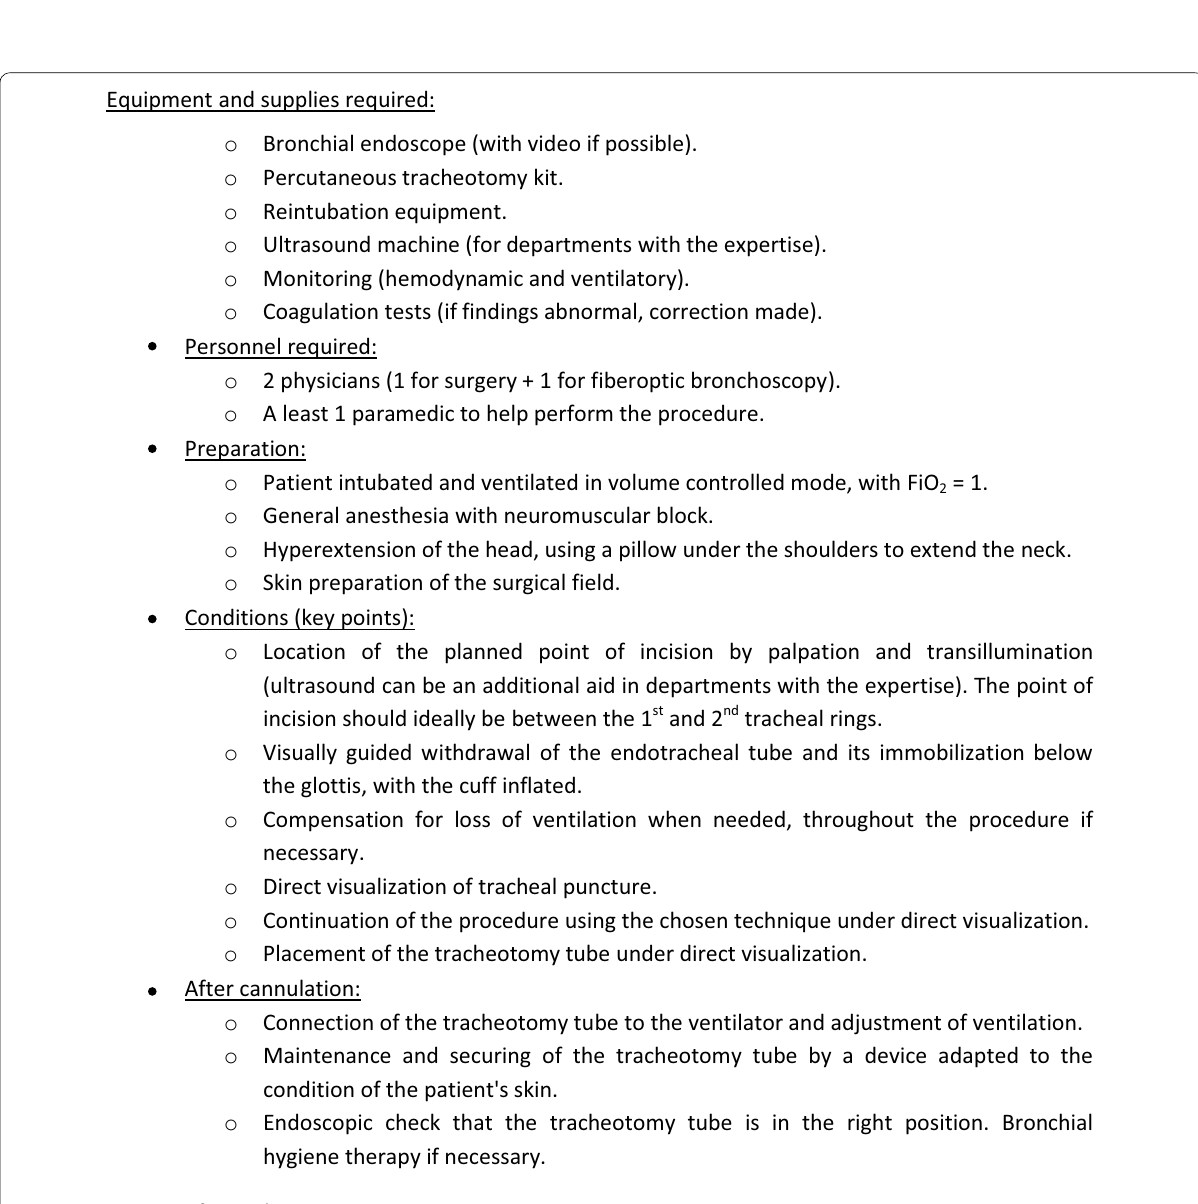
Fig. 1 Proposal for a protocol associated with guideline 3.5 (Expert